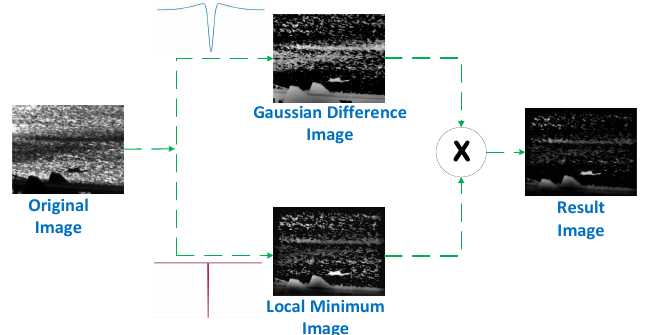
Figure 6. Flowchart of preprocessing algorithm to improve target saliency.